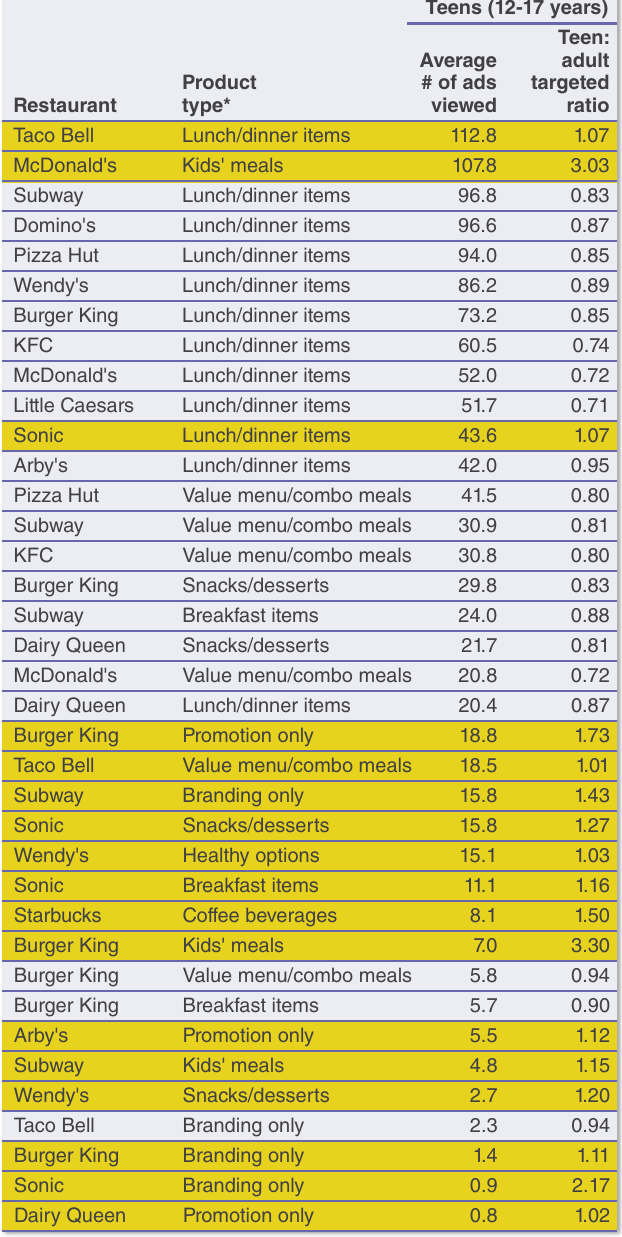
Table 21. Restaurants and product types advertised most often to teens